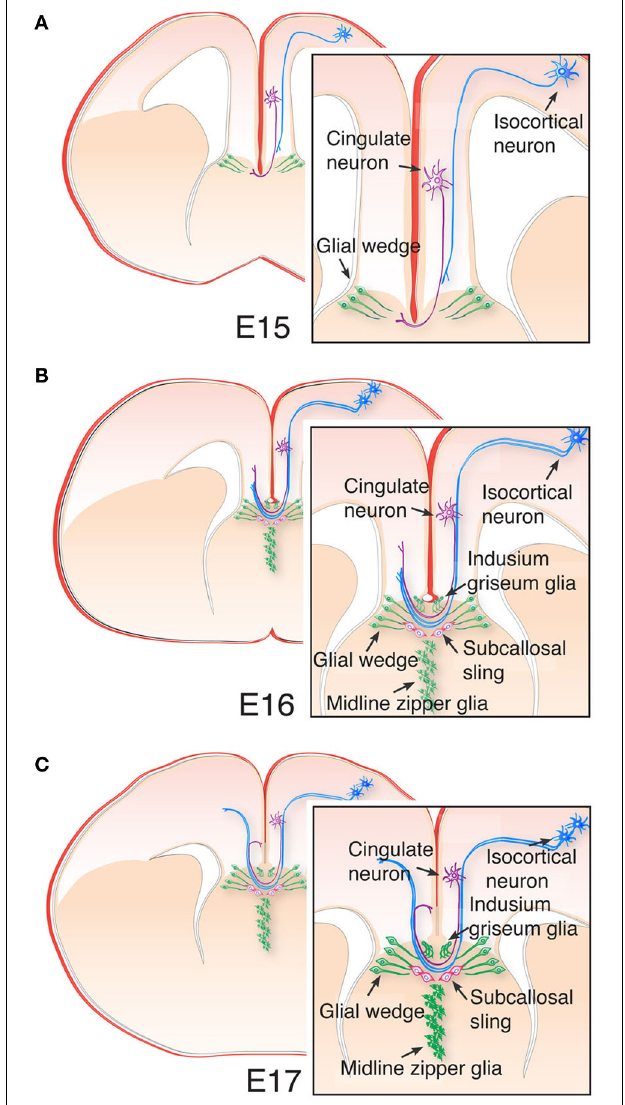
FIGURE 5 | Cellular architecture of the telencephalic midline and callosal development. (A) The ventral-most boundary of the corpus callosum is established by glial wedge cells, as cingulate pioneering axons first cross the midline at E15, while the more laterally located isocortical axons grow toward the midline following cingulate axons. (B) At E16, a small number of isocortical axons have crossed the midline, and the indusium griseum glia and midline zipper glia are now detectable with Gfap immunohistochemistry. The indusium griseum glia provide the dorsal boundary of the corpus callosum. In addition, cells of the subcallosal sling begin to migrate toward the midline, just beneath the corpus callosum. (C) By E17, isocortical axons have started crossing the midline, and cingulate pioneering axons are projecting to homotopic targets in the contralateral hemisphere. Midline crossing of callosal axons continues during early postnatal stages in mice.